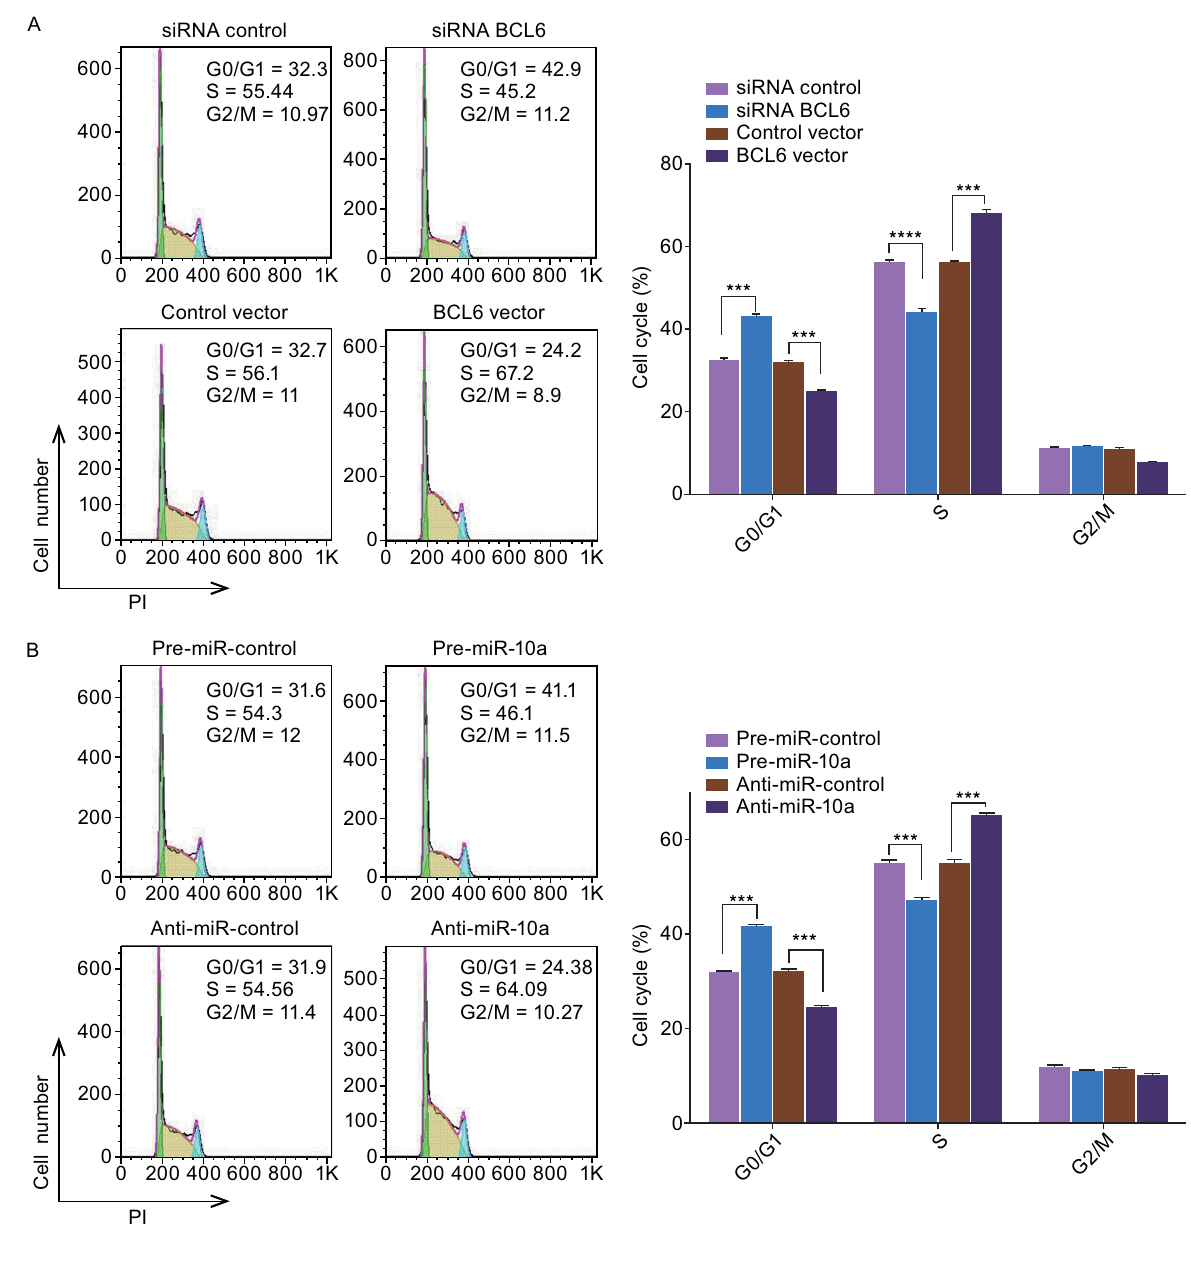
Figure 4. The role of miR-10a targeting BCL6 in the regulation of cell cycle in DLBCL cells. (A) Cell cycle pro fi les were analyzed using fl ow cytometry afer the transfection of OCI-LY7 cells with equal dose of control siRNA, BCL6 siRNA, control vector or BCL6 overexpression vector. (B) Cell cycle pro fi les were analyzed using fl ow cytometry afer the transfection of OCI-LY7 cells with equal dose of pre-miR-control, pre-miR-10a, anti-miR-control or anti-miR-10a. (C) Cell cycle pro fi les were analyzed using fl ow cytometry afer the transfection of OCI-LY7 cells with pre-miR-control plus control vector, a pre-miR-control plus BCL6 overexpression vector, pre-miR-10a plus control vector, or pre-miR-10a plus BCL6 overexpression vector. The panel shows hisograms of cell numbers (y axis) against DNA content (x axis) determined by measuring fl uorescence intensity. Numbers denote the percentages of cells in the G0/G1, S and G2/M phases. Left panel: representative image; right panel: quantitative analysis. Data are the mean ± SEM of 3 independent experiments performed in triplicate, ** P < 0.01; *** P <